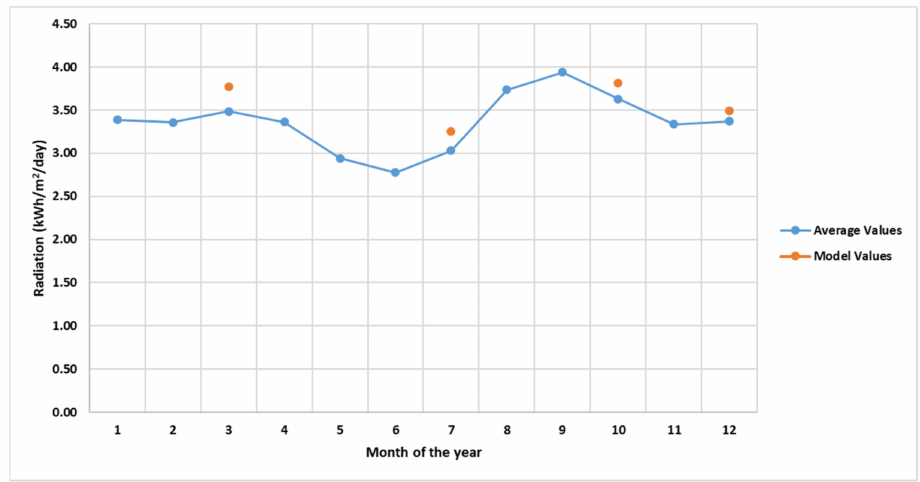
Figure 4. Radiation profile.